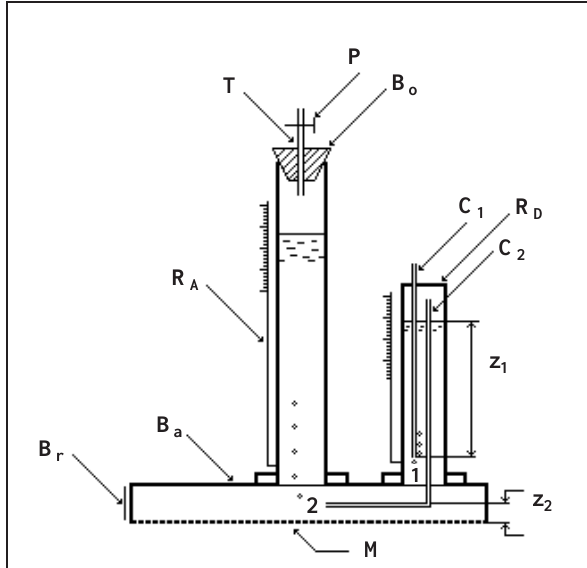
Figura 1. Esquema do permeâmetro de disco utilizado. M é uma membrana de nylon mantida ) pelo bracelete de borracha presa na base (B a (B ); R é o reservatório de alimentação; B r A uma rolha de borracha;T é um tubo munido de um duto flexível e de uma pinça de Mohr (P); é o tubo que permite a passagem de ar pelo C 1 reservatório de despressurização R tubo que realiza a comunicação entre R z é a coluna de água sobre a extremidade 1 do 1 tubo C e z é o desnível entre a extremidade 2 1 2 e a B do tubo C 2 a